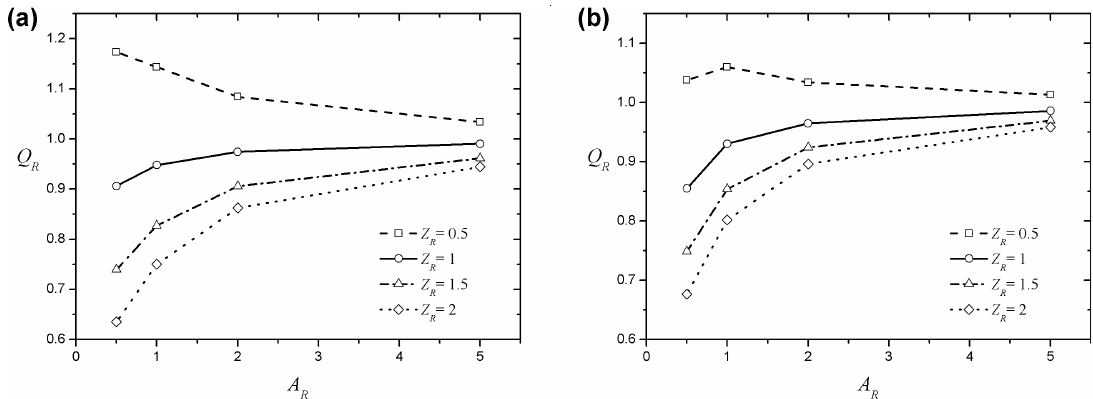
Figure 6. The flow rate ratio according to the channel aspect ratio and zeta potential ratio at L D = 0.03: ( a ) n = 0.8 and ( b ) n =